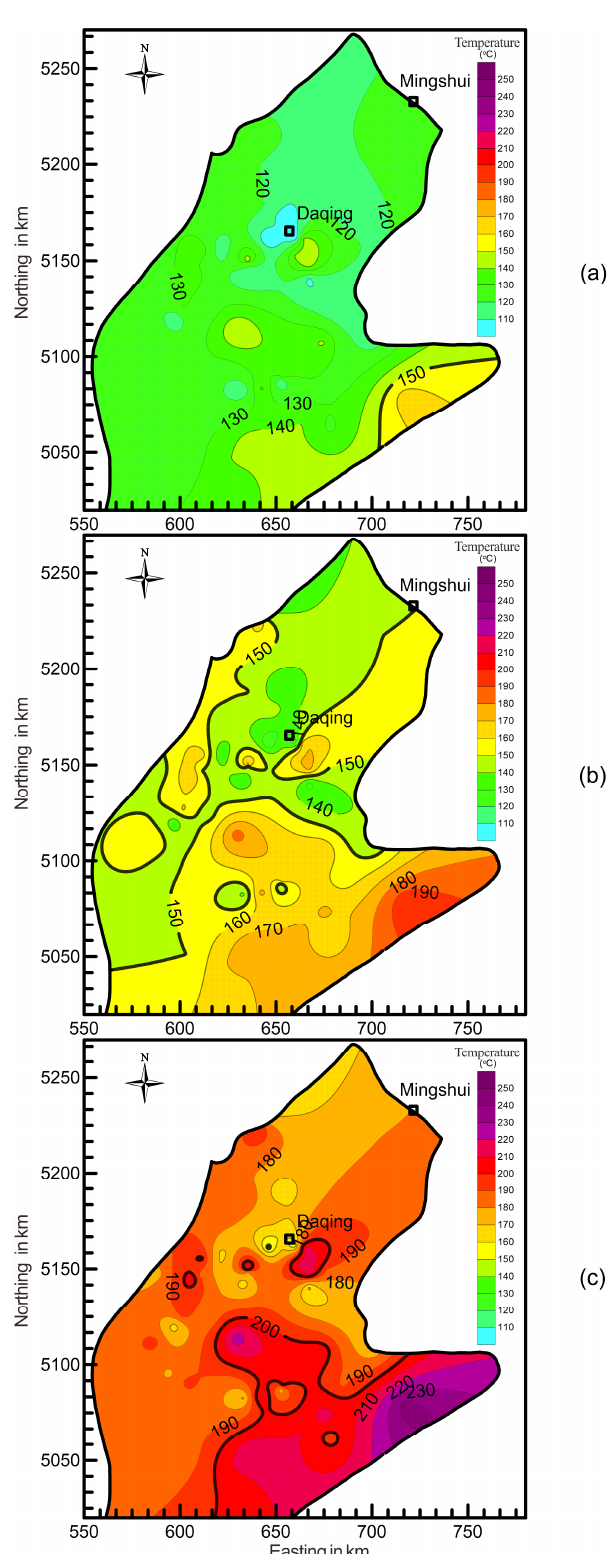
Figure 4. The temperature distribution at the different depth of 3 km ( a ), 4 km ( b ), and 5 km ( c ). The thick black lines show the isotherm of 150 °C and 200 °C.